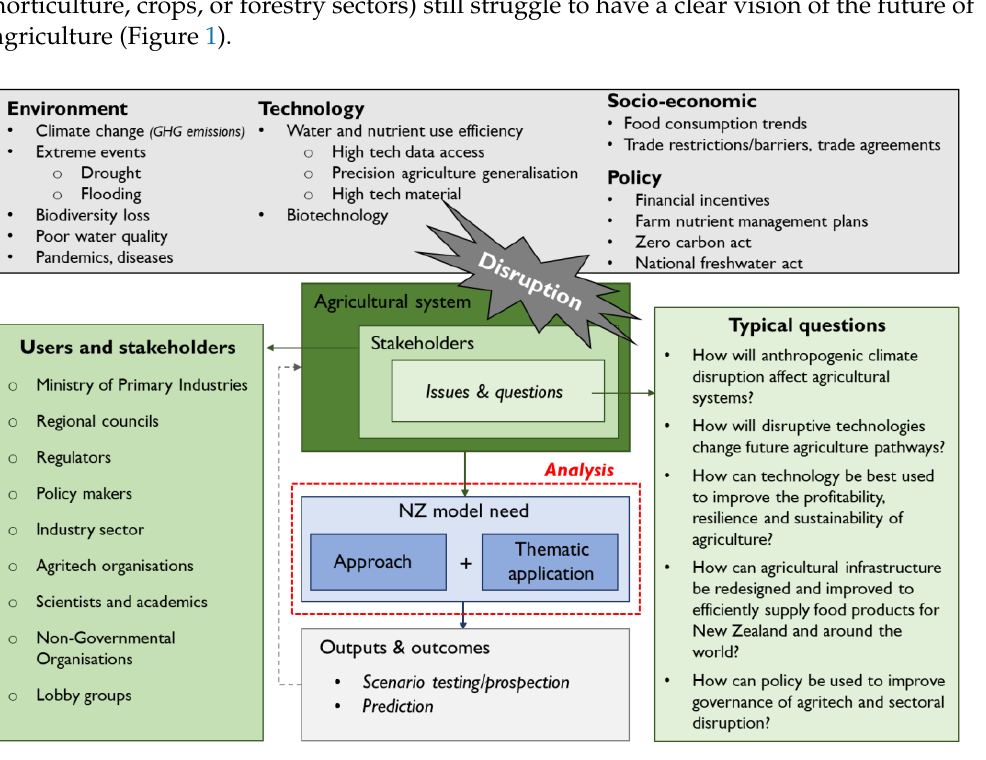
Figure 1. Flow chart from disruption of NZ agricultural system, modelling need, to solution design. Surrounding in red, where an analysis and synthesis of knowledge is proposed.